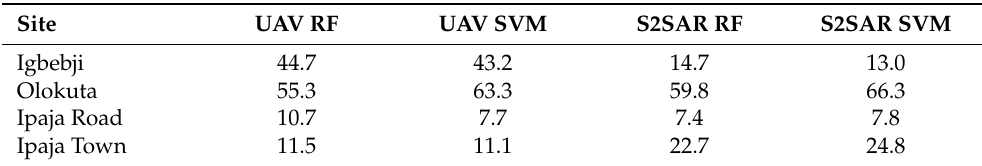
Table 7. Estimated banana area (ha) based on UAV and Sentinel 2 + SAR